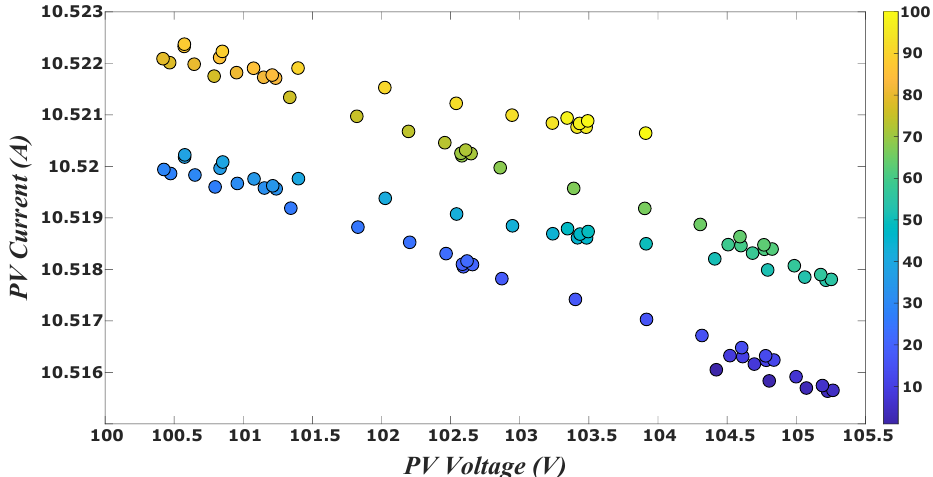
Figure 9. Measurement window with changes in irradiance and temperature.